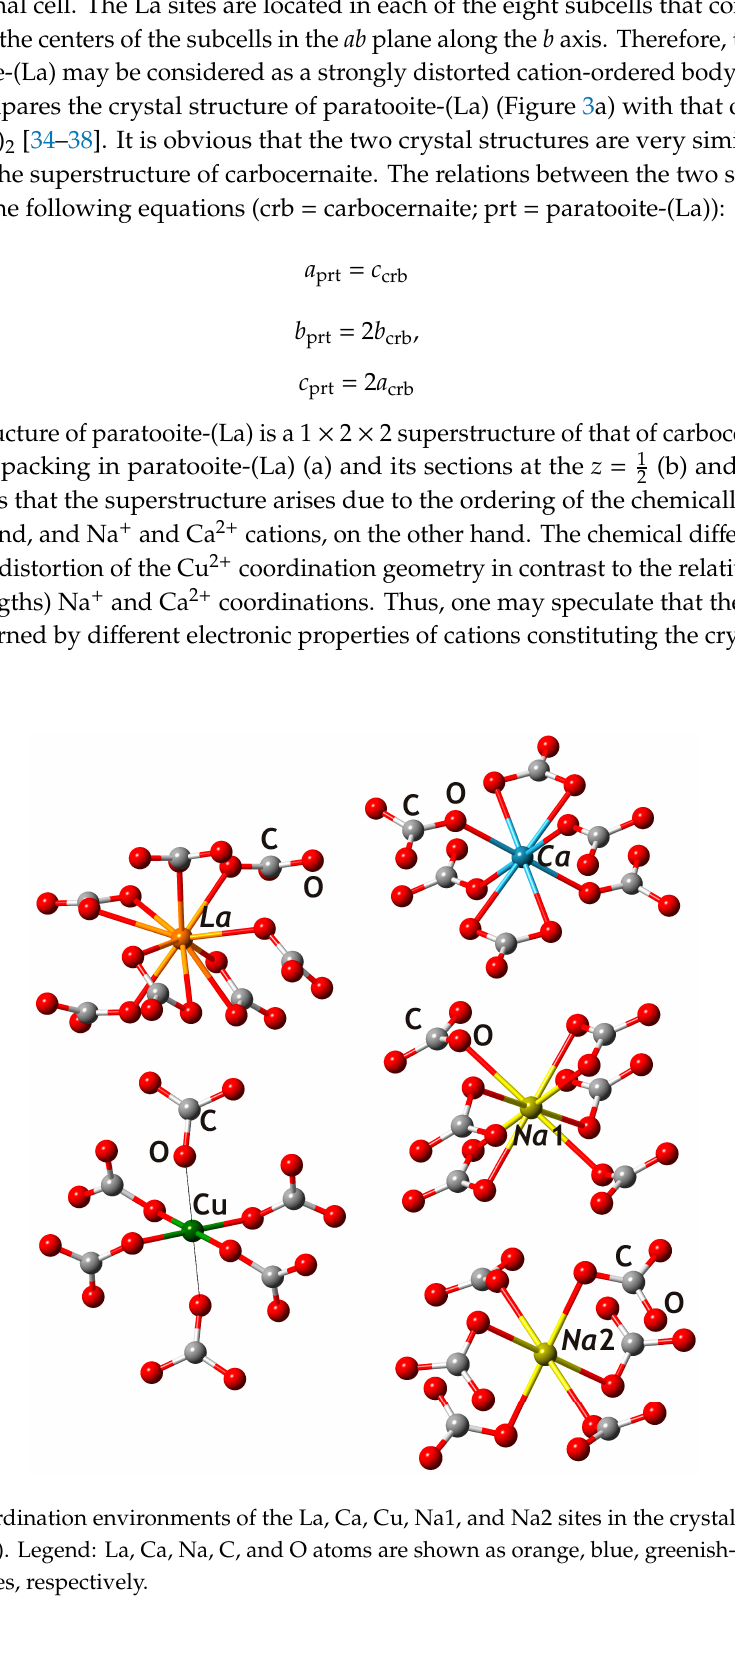
Figure 3. The crystal structures of paratooite-(La) ( a ) and carbocernaite ( b ). Legend is as in Figure 1; Sr atoms are shown as yellow spheres, and carbonate triangles are shaded in gray. 3.4. Crystal-Chemical Formula According to the chemical and crystal-structure data, the crystal-chemical formula of paratooite- (La)